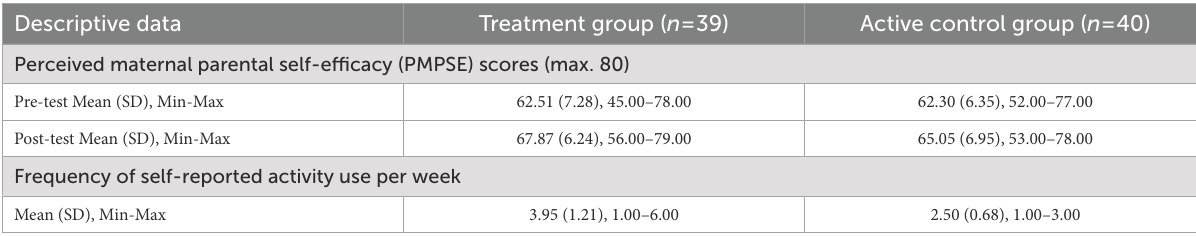
TABLE 3 Group mean (SD), minimum-maximum for PMPSE scores at pre-test and post-test, as well as frequency of self-reported activity use during 4-week intervention period. Descriptive